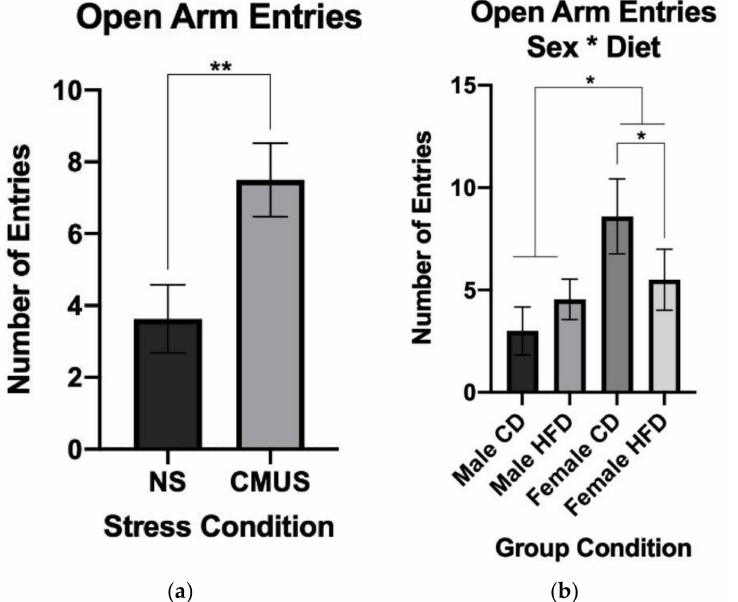
Figure 6. ( a ) Open arm entries in the EZM. Mice in the CMUS condition entered the open arm significantly more than those in the NS condition (** p < 0.01). ( b ) Open arm entries in the EZM (sex*diet). Female mice made significantly more entries into the open arm of the EZM than male mice. Female mice given a HFD made significantly fewer open arm entries compared to female mice in the CD condition (* p < 0.05). Females on a CD made a higher number of open arm entries compared to CD males in both NS ( p < 0.05) and CMUS conditions ( p =